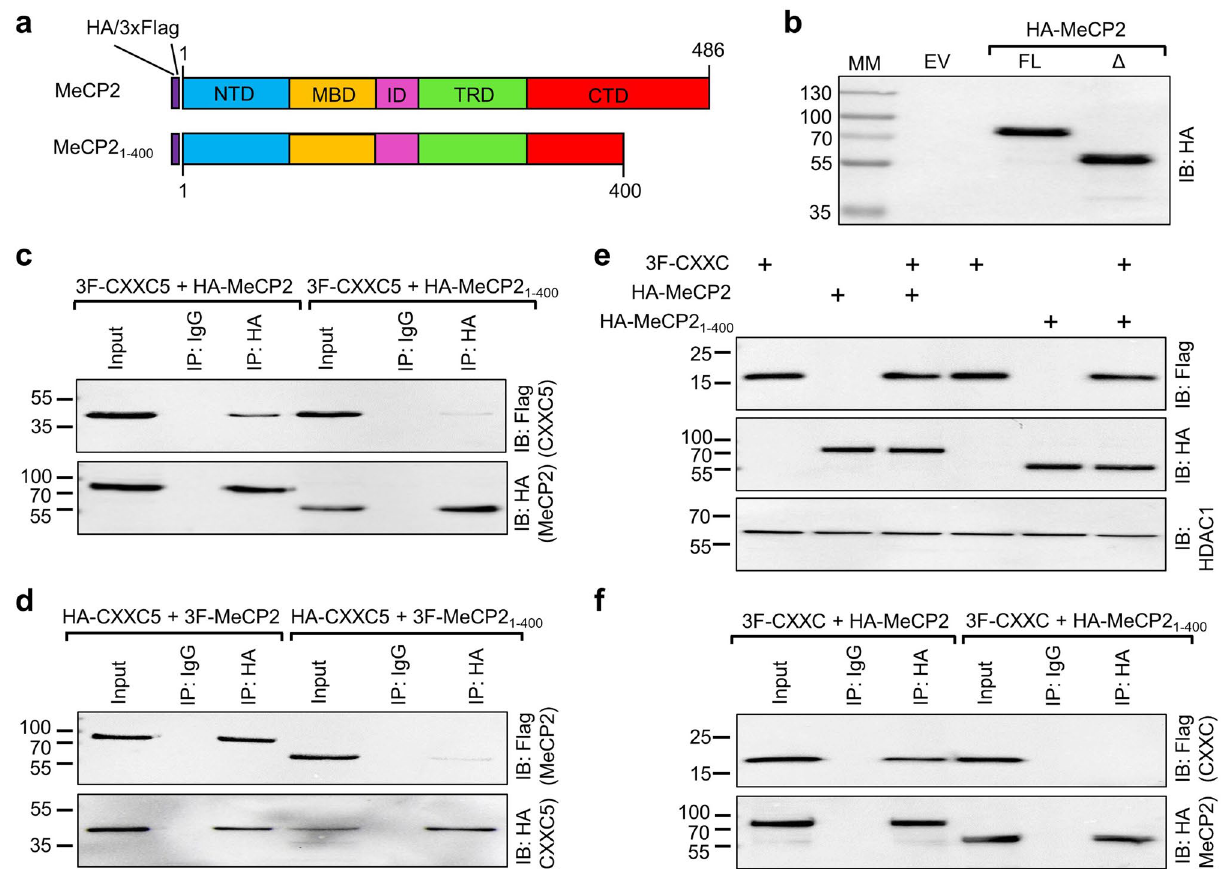
Figure 7. Identification of a sub-region of MeCP2 critical for interacting with CXXC5. ( a ) Schematics of the wild-type MeCP2 and the carboxyl-terminally truncated MeCP2 1-400 bearing the 3xFlag (3F) or the HA (HA) tag at the amino-terminus. The N-terminal domain (NTD), methyl CpG binding domain (MBD), inter-domain (ID), transcription repression domain (TRD), and C-terminal domain (CTD) containing a WW protein interaction domain are indicated. ( b ) The synthesis of MeCP2 (FL) or HA-MeCP2 1-400 (Δ) in transiently transfected cells was assessed with WB using the HA antibody. EV indicates empty vector as control and MM denotes molecular masses in kDa. ( c,d ) HEK293 cells were transiently co-transfected with the expression vector bearing cDNA for 3F-CXXC5 and HA-MeCP2 or HA-MeCP2 1-400 . Nuclear extracts were subjected to Co-IP with the HA or the isotype-matched IgG. The precipitates were subjected to WB using the Flag antibody. The membrane was re-probed with the HA antibody. 10% of nuclear extracts was used as input control. Molecular masses (MM) in kDa are indicated. ( e ) Nuclear extracts of HEK293 cells transiently co-transfected with an expression vector bearing cDNA for the 3F-CXXC domain (3F-CXXC), HA-MeCP2, or HA-MeCP2 1-400 , were subjected to WB using the Flag, HA or HDAC1 antibody. Molecular masses (MM) in kDa are indicated. ( f ) Nuclear extracts, 500 µg, co-synthesizing CXXC , and HA-MeCP2, or HA-MeCP2 1-400 , were subjected to Co-IP with the HA antibody or the isotype-matched IgG. The precipitates were subjected to WB using the Flag antibody. The membrane was also re-probed with the HA antibody. 10% of nuclear extracts was used as input control. Molecular masses (MM) in kDa are